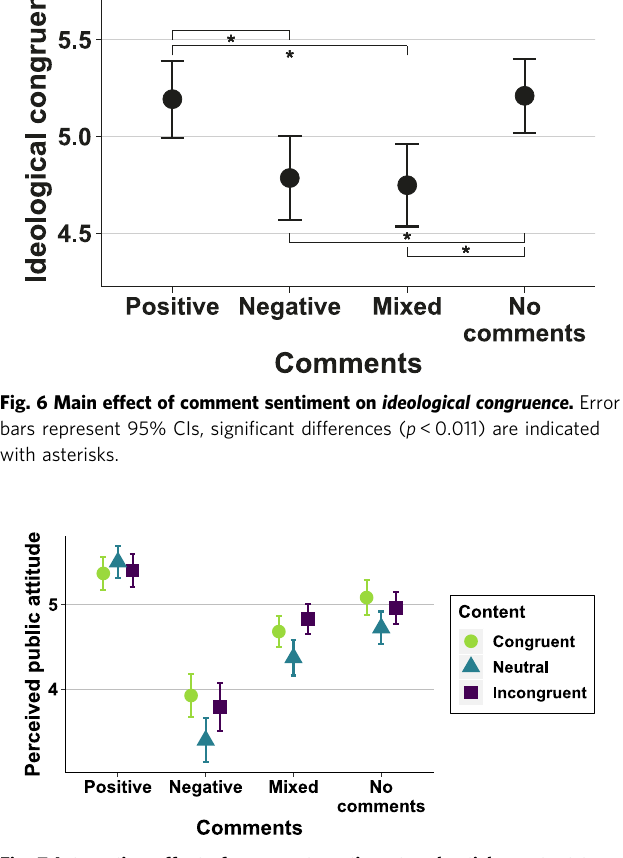
Fig. 7 Interaction effect of comment sentiment and article-content type on perceived public attitude . Error bars represent 95% CIs.